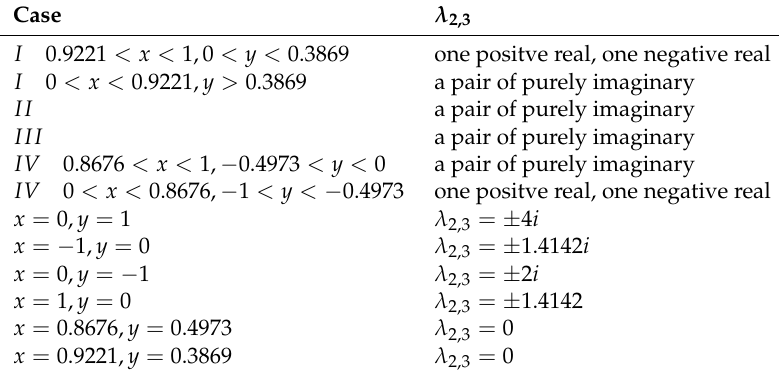
Table 3. Eigenvalues of the system (3) for k =